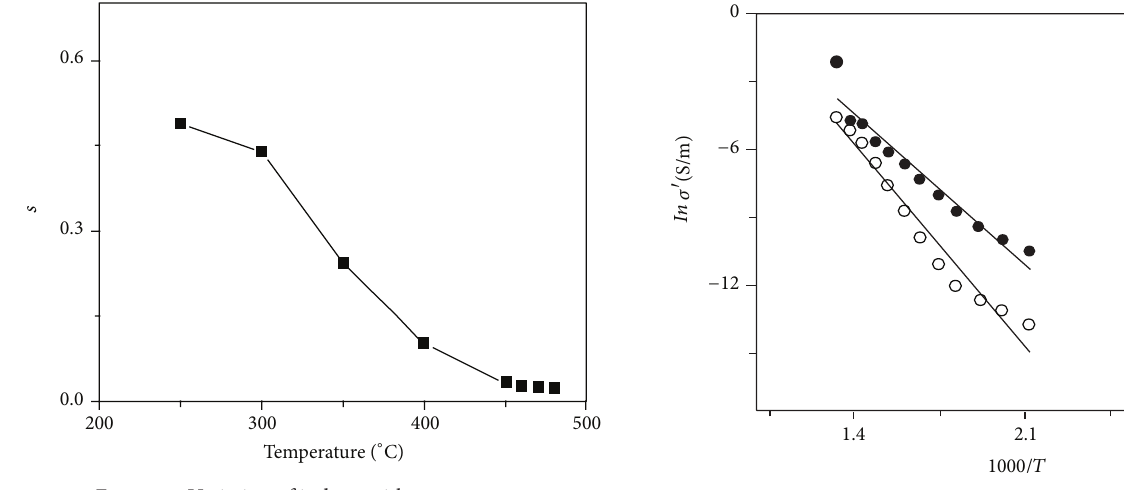
Figure 7: Variation of index 𝑠 with temperature.